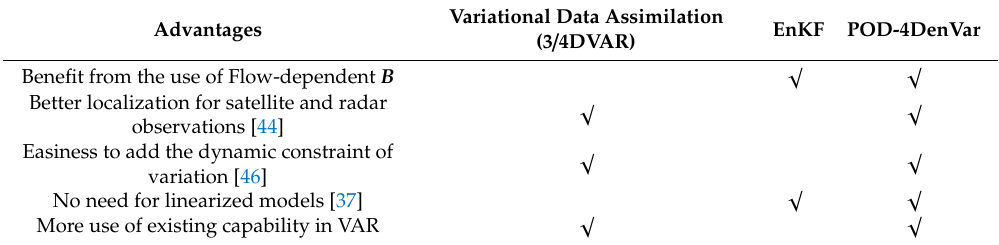
Comparison of variational data assimilation, ensemble Kalman filter (EnKF), and POD-4DenVar